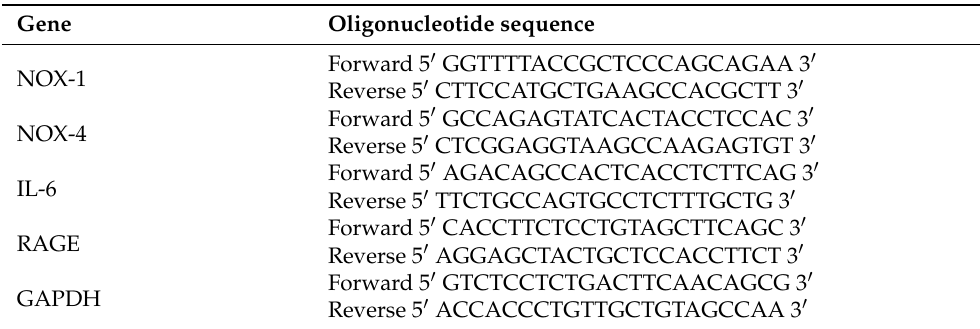
Table 2. Primer sequences for quantitative real-time PCR